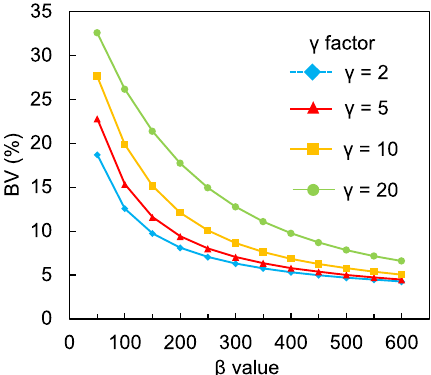
Fig. 3 Background variability as a function of β 50–600 for each γ